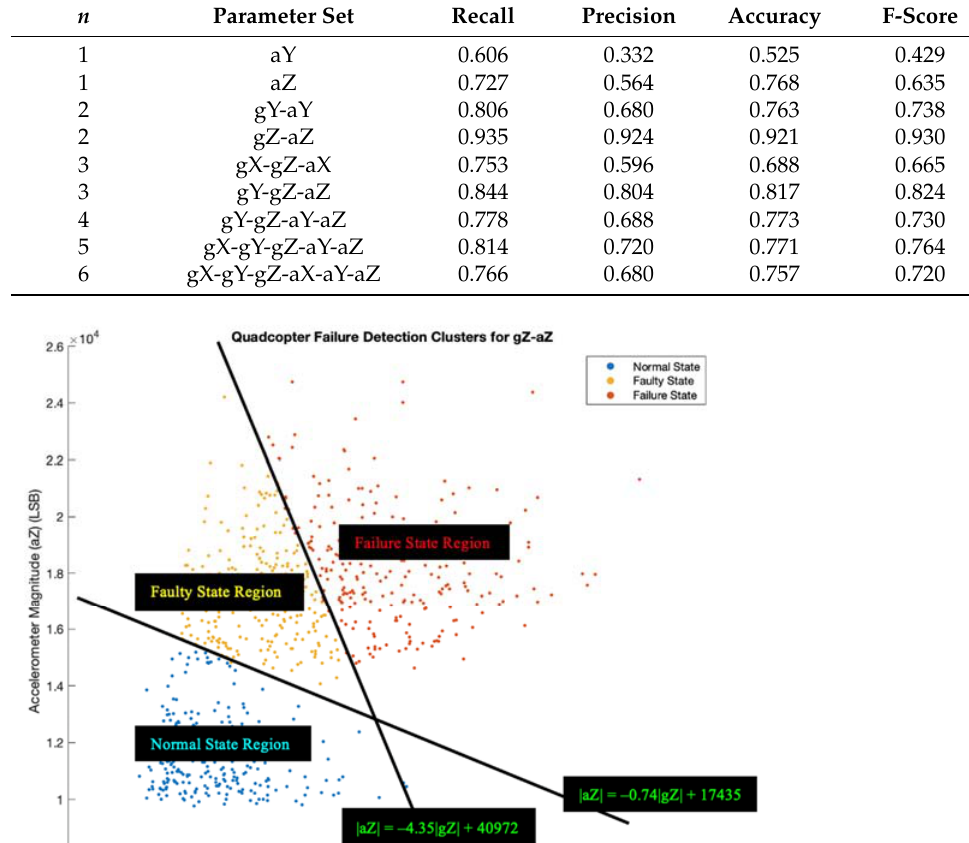
Table 5. Performance Metrics for Parameter Sets.